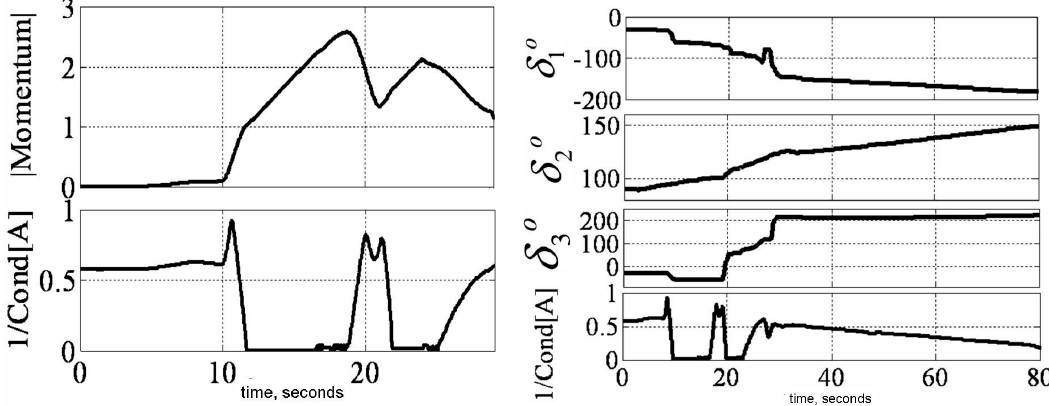
Figure 10. EXPERIMENTATION: momentum, matrix condition, and gimbal rates.